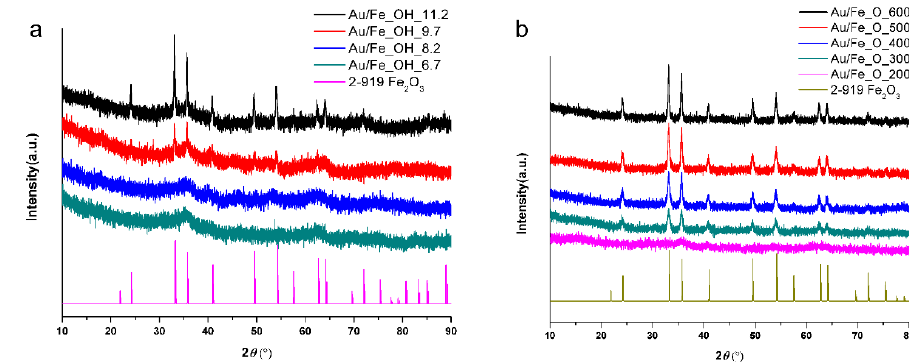
Figure 1. XRD patterns of fresh Au/FeO x catalysts: ( a ) Au/Fe_OH and ( b ) Au/Fe_O.